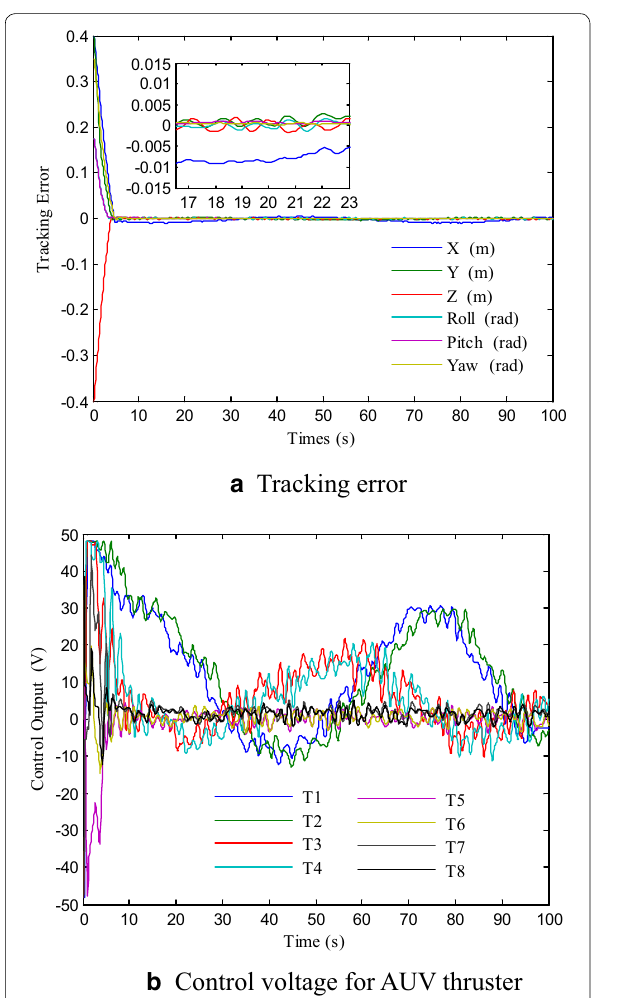
a Tracking error